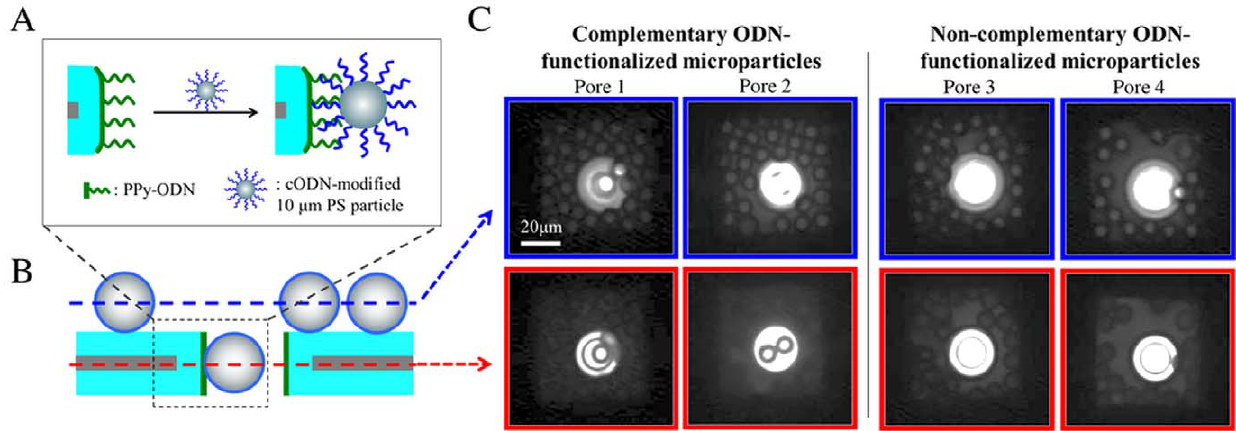
Figure 2. Selective capture of polystyrene (PS) microparticles in functionalized micropores. A. Schematic illustration of the specific interaction between ODN probe-functionalized micropore wall and the cODN target-functionalized PS particles. B. Schematic representation of the focusing planes for image acquisition by optical transmission microscopy. C. Photographs of ODN probe-modified micropores after incubation with cODN (pores 1 and 2) or ncODN (pores 3 and 4) target-functionalized particles by focusing the microscope objective on microparticles settled on the micropore membrane (blue-framed images) or inside the micropores (red-framed images).